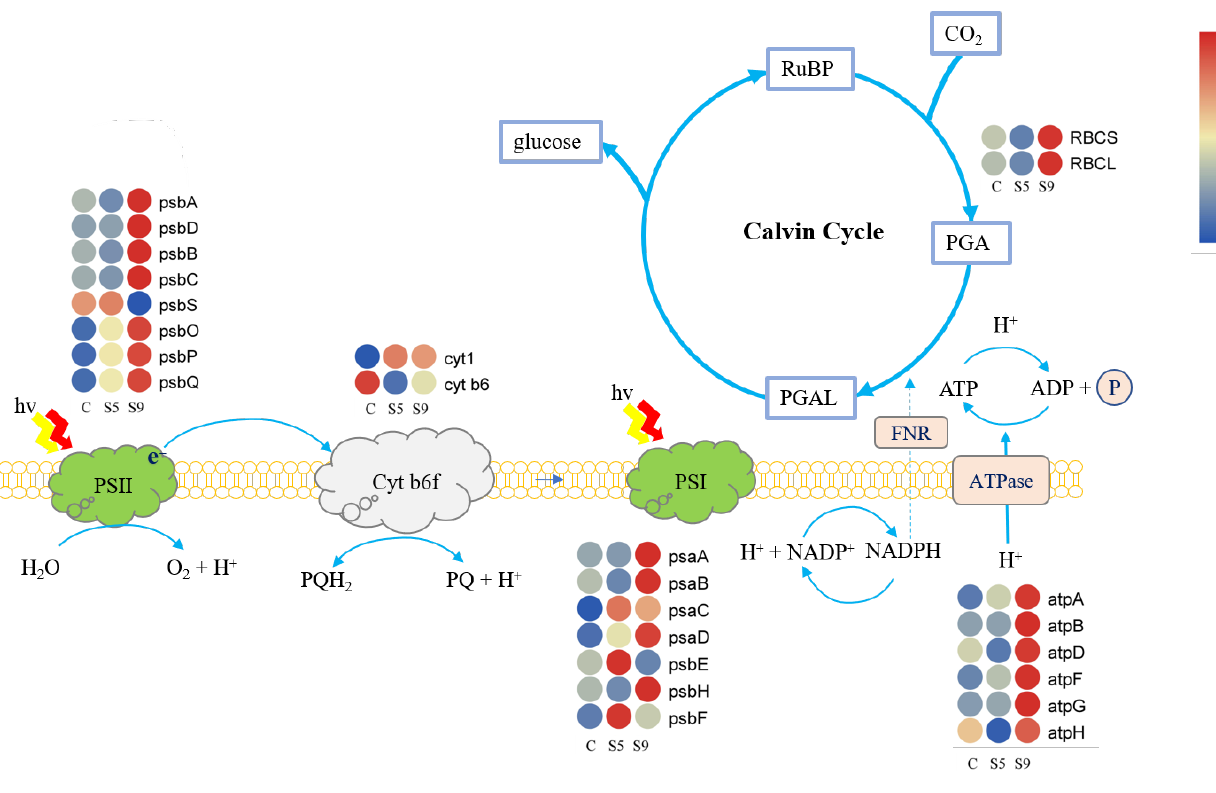
Figure 6. Heat map of gene expression in photosynthesis. (Filled colors indicate expression levels based on z-score normalization.) (C: salinity 30 psu; S5: salinity 50 psu; S9: salinity 90 psu.) RuBP: Ribulose 1,5biphosphate; PGA: 3Phosphoglycerate; PGAL: Glyceraldehyde